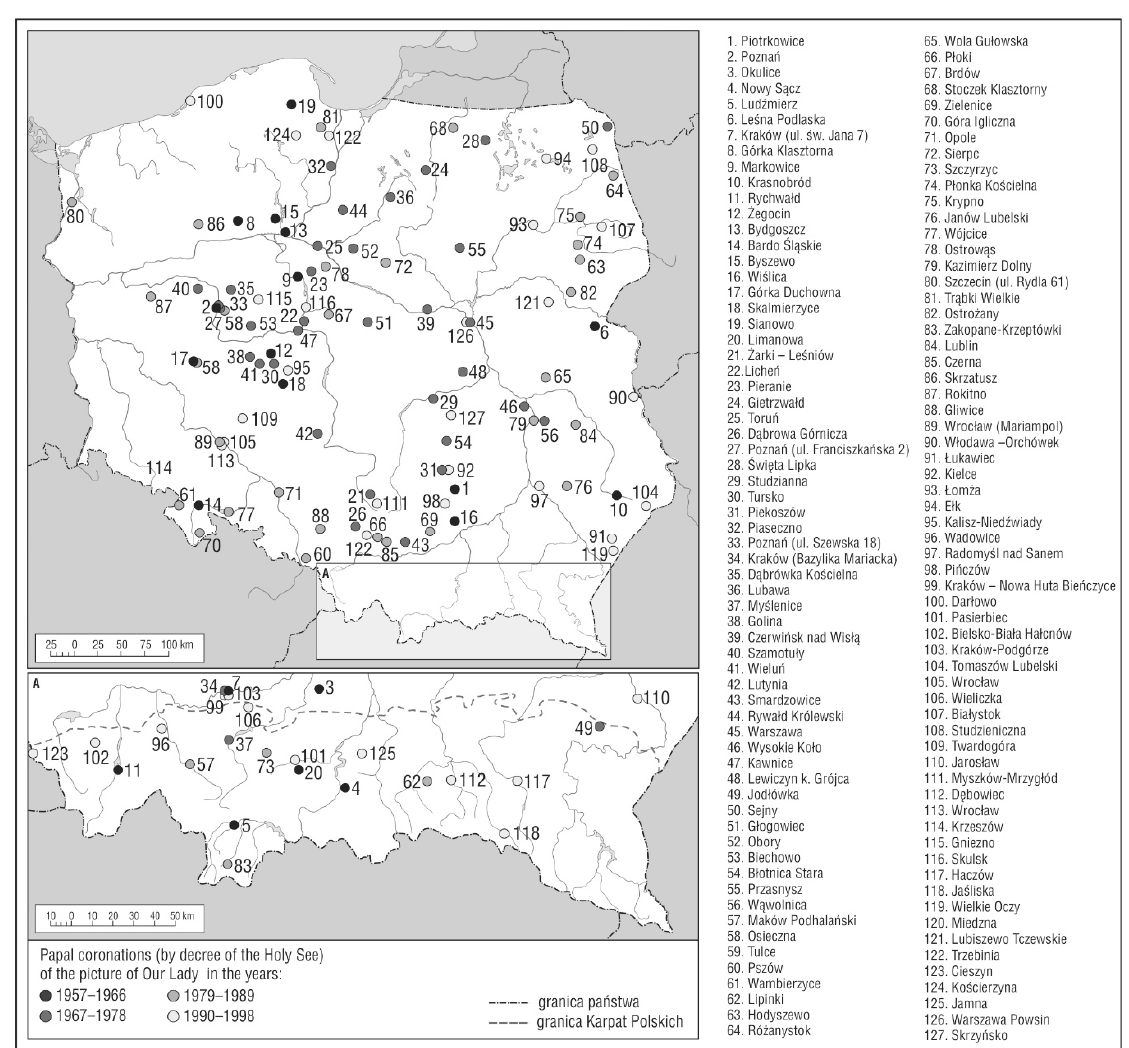
Figure 3. Papal coronations (by decree of the Holy See) of the picture of Our Lady in Poland during the Vatican II era (1948–1998). Source: author.